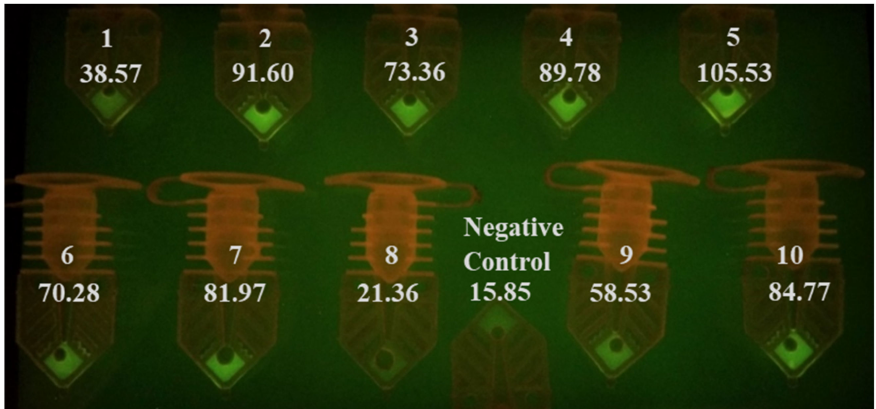
Figure 5. PCR tubes after a RT-PCR run using 3 µ L of 10-min, 95 ◦ C heat-inactivated samples. Nine out of ten samples can be identified as positive based on the fluorescence signal di ff erence when compared to the negative control. The RT-PCR run was completed in 12 min (90 s / 30 s / 40 × (6 s / 9 s)). The signal intensity measured by ImageJ is listed under the sample